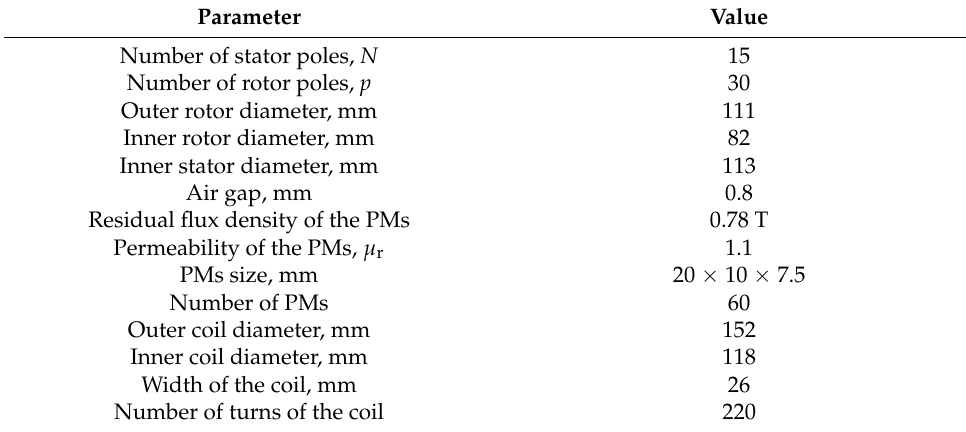
Figure 1. The initial configuration of the single-phase transversal flux machines ( Т FM) with an inner rotor. Table 1. Key parameters of the single-phase TFM with an inner rotor.